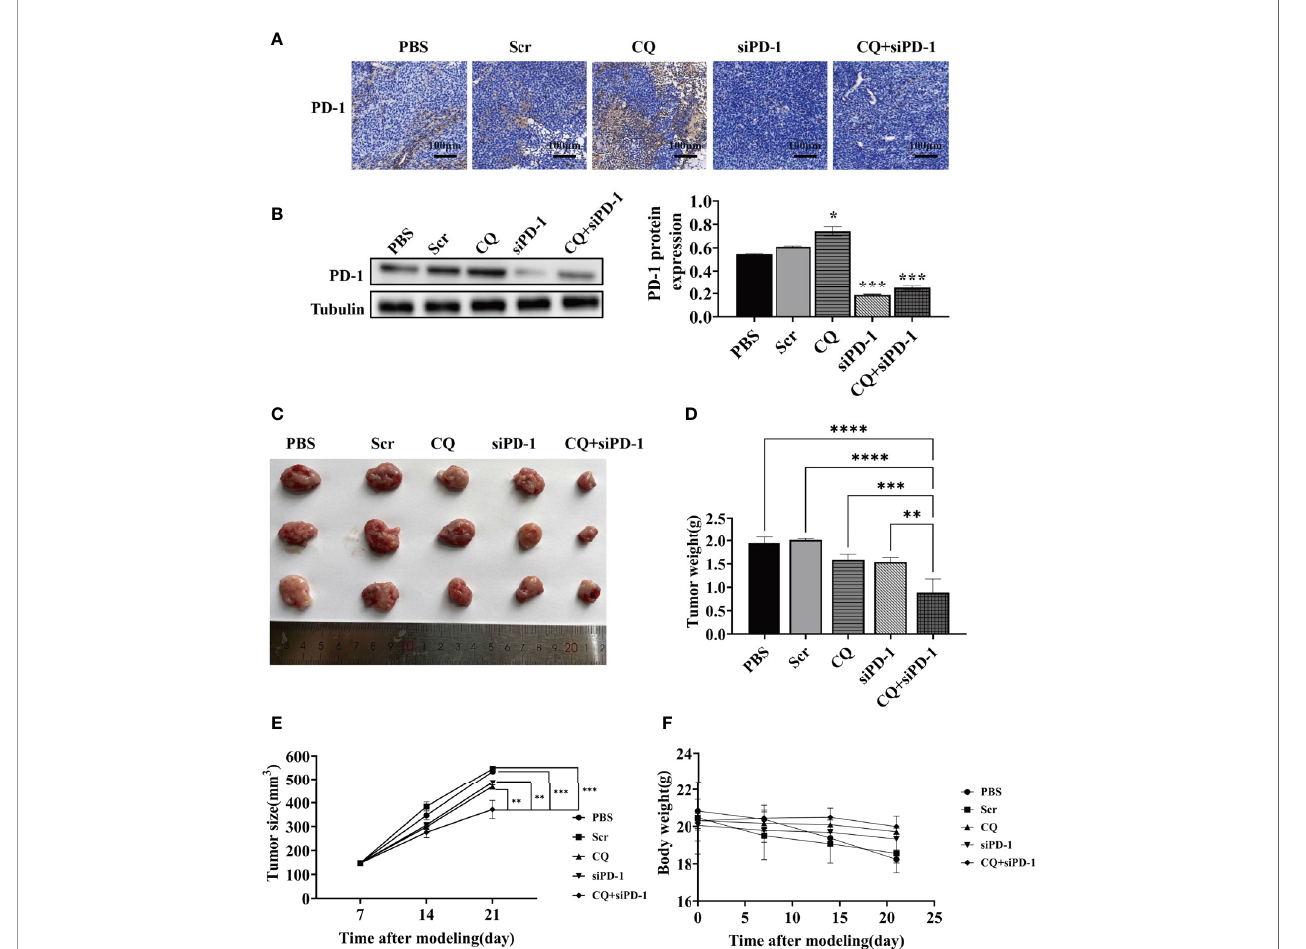
FIGURE 4 | Effect of various treatments on tumor growth in vivo . BALB/c mice were subcutaneously inoculated with 1×10 6 CT ‐ 26 cells and treated with PBS, attenuated Salmonella carrying the scrambled siRNA plasmid, CQ, attenuated Salmonella carrying PD ‐ 1 siRNA, or CQ plus attenuated Salmonella carrying PD ‐ 1 siRNA. (A) IHC detects the expression of PD-1 in tumor tissues. (B) The protein levels of PD-1 in tumor tissue after the indicated treatments were evaluated by Western blotting analysis. (C) Images of the representative tumors in each group on posttreatment day 14. (D) Tumor weight analysis. (E) Tumor size analysis. (F) Body weight analysis. (* p < 0.05, ** p < 0.01, *** p < 0.001, **** p < 0.0001 vs CQ+siPD-1